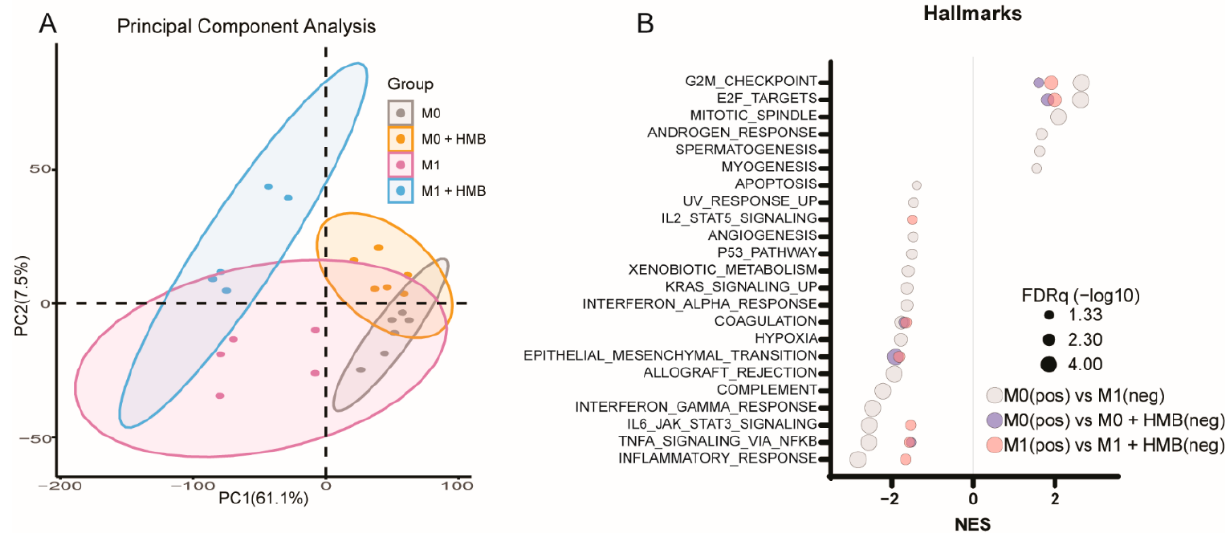
Figure 6. Transcriptomic analysis of bone marrow-derived M0- and M1-like macrophages supplemented with or without HMB ( A , B ). ( B ) Principal component analysis of M0/M1 macrophages treated with HMB ( n = 5–6/group). Significant (FDRq < 0.05) GSEA enrichments from Hallmark gene sets resulting from comparing M0 vs. M1 (gray), M0 vs. M0 + HMB (red), and M1 vs. M1 + HMB (blue); FDRq is denoted by the bubble size.